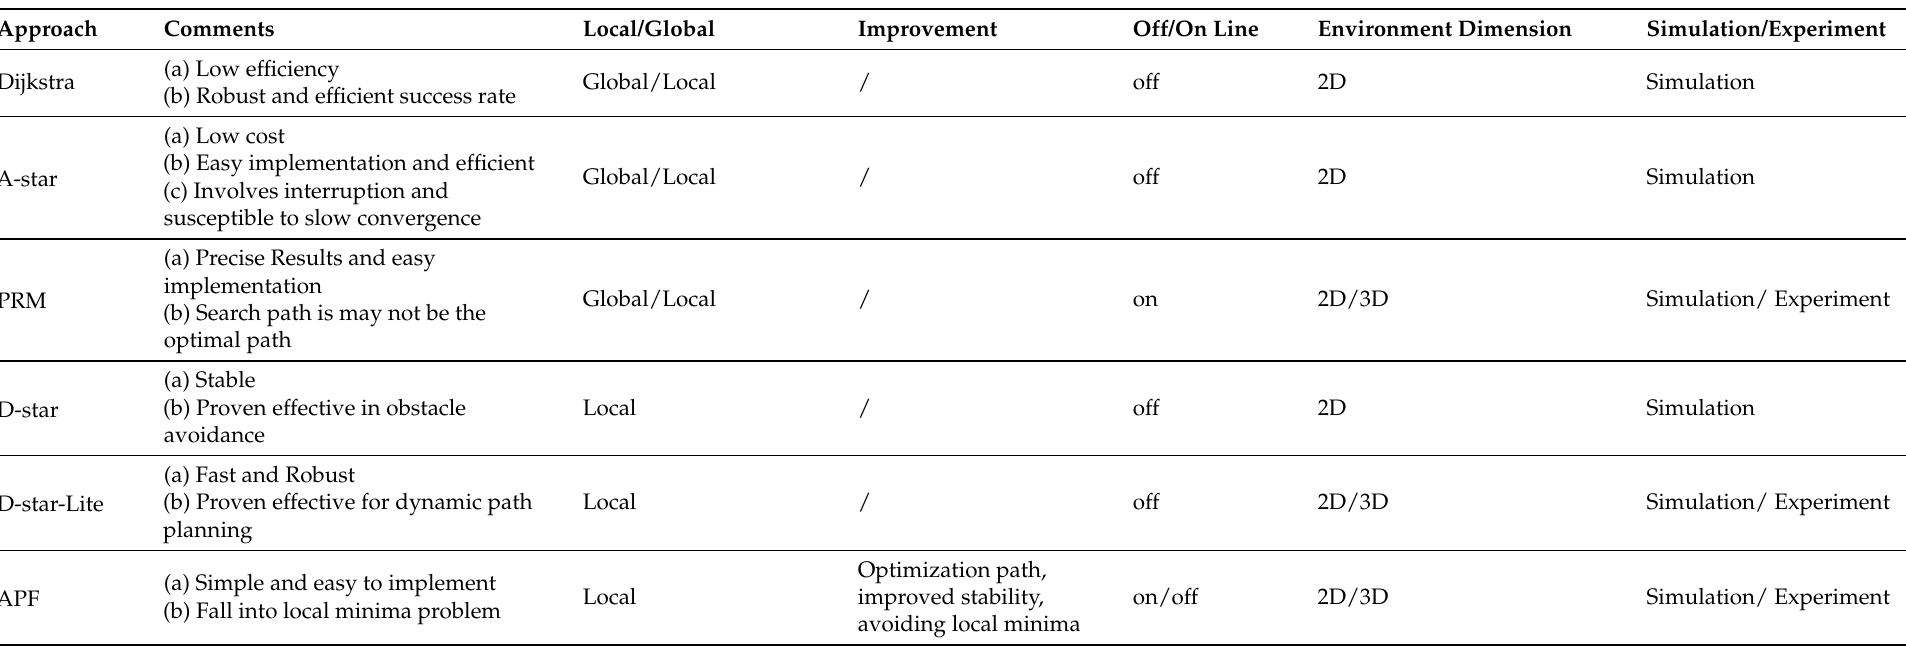
Table 8. Literature Survey of all Possible Path